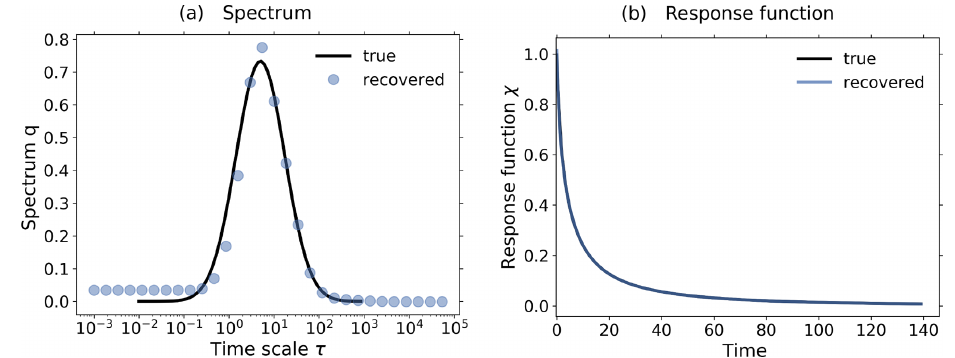
Figure E9. Response function χ(t) and spectrum q λ recovered from toy model data taking the RFI parameters M = 30, log τ min = − 3, and log τ max = 5. Blue dots in (a) and blue line in (b) indicate the recovered values for the spectrum and for the response function, while black lines indicate their “true” values.